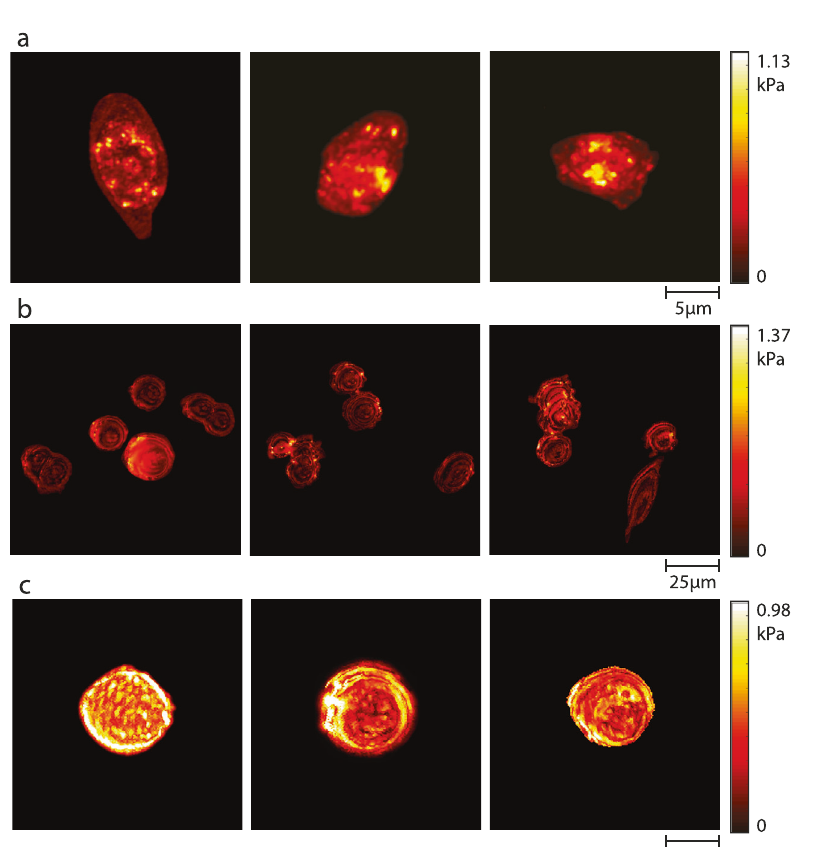
Fig. 3 | Stiffness and thickness measurements for reference microbeads, HCT116 cells, and CTC-mimicking HCT116 cells. a Stiffness and b thickness measurements represented as measured average values and standard deviations. The sample sizes for the experiment groups were n =50, n =50, n =35, and n =25 across 3 independent experiments for PAA microbeads, agarose microbeads, epi- thelialHCT116cells,andTGF- β treatedHCT116cells(CTC-mimickingHCT116cells),